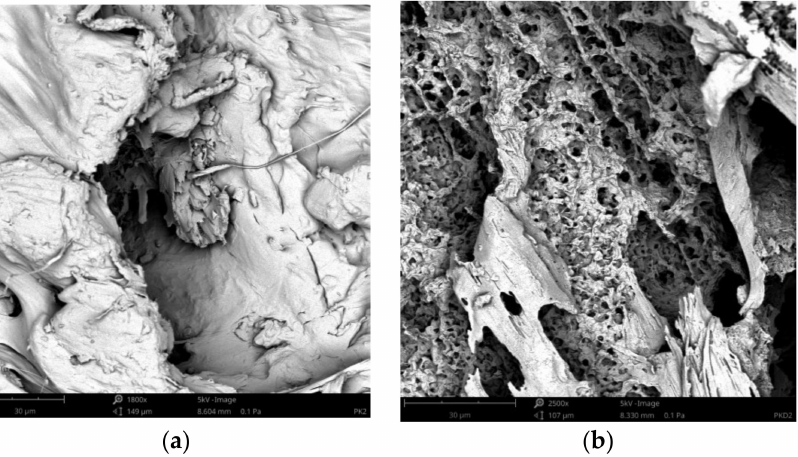
Figure 11. SEM images of sample P2 before the treatment by proteinase K ( a ) and sample P2 after the treatment by proteinase K ( b